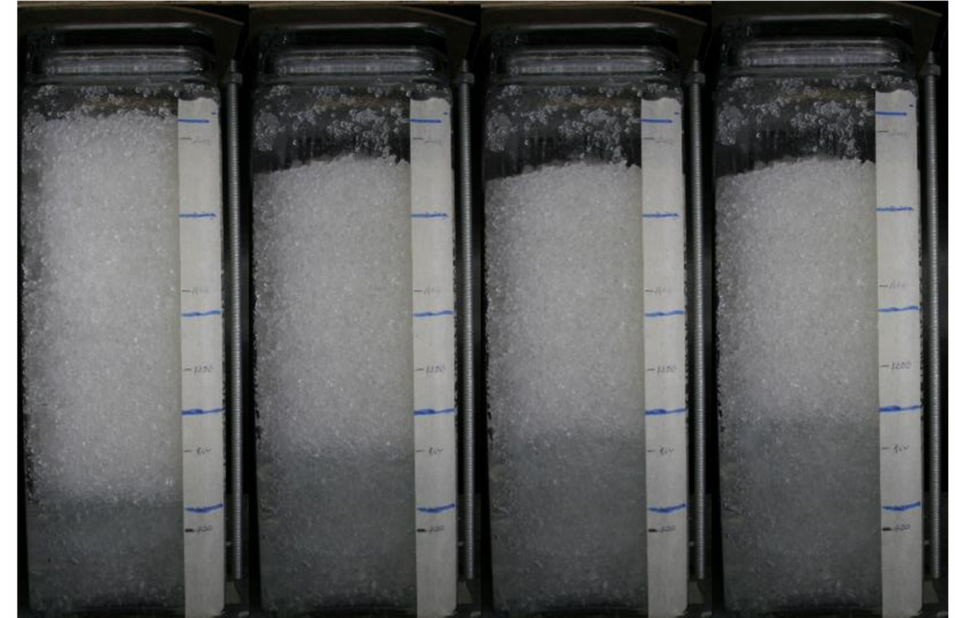
Figure 5. Sample image sequence from test 5 taken at time intervals t = 0 s, t = 30 s, t = 60 s, and t= 90 s.